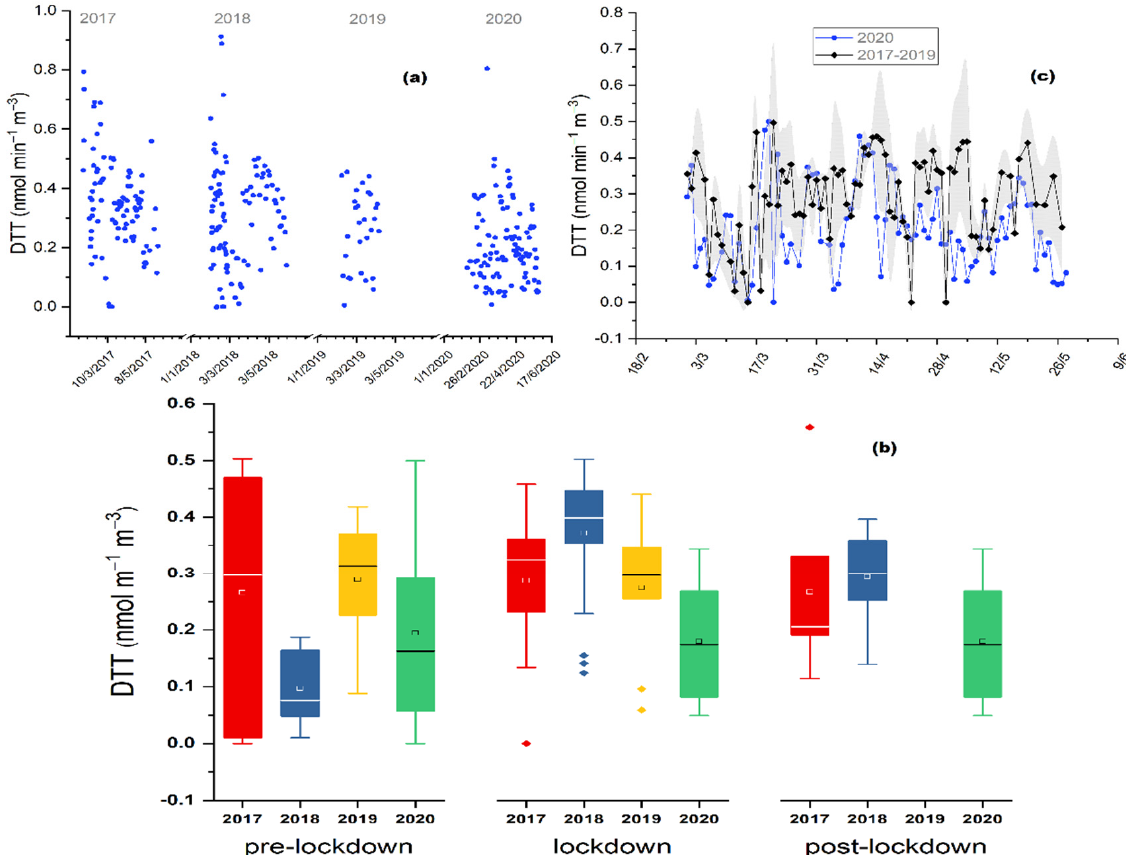
Figure 2. ( a ) Values of water-soluble DTT activity (nmol min − 1 m − 3 ), from March 1 to May 10, for the years 2017 to 2020; ( b ) Average values and standard deviations of water-soluble DTT activity (nmol m − 1 m − 3 ); for pre-lockdown (1–22 March), lockdown (23 March–10 May) and post-lockdown period, from 2017 to 2020, at the Thissio site. The dots represent outlier values; ( c ) Water-soluble DTT activity (nmol m − 1 m − 3 ) 3-year (2017–2019) average daily values (standard deviations marked as grey area), compared to daily values of 2020, from 1 March to 10 May, at the Thissio site.